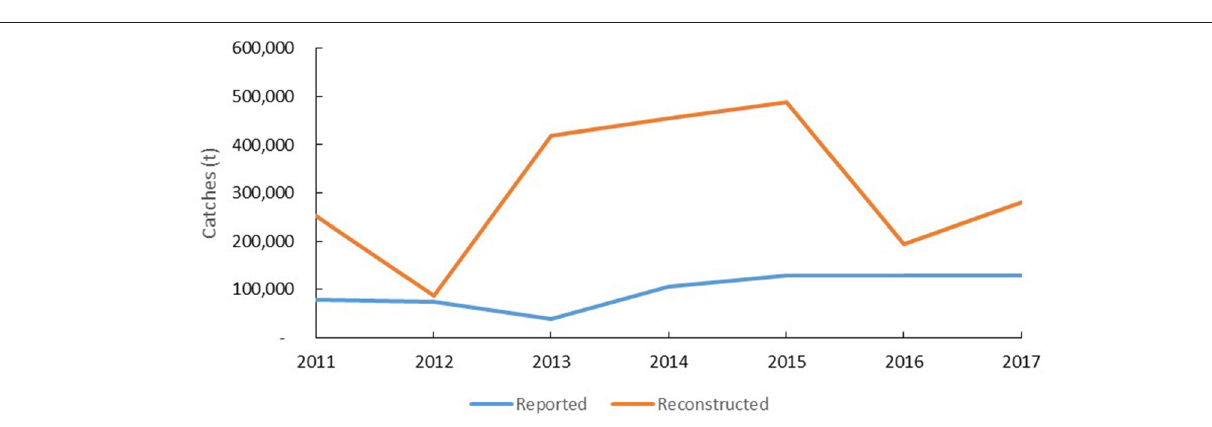
more effective than monitoring of industrial fisheries in Guinea